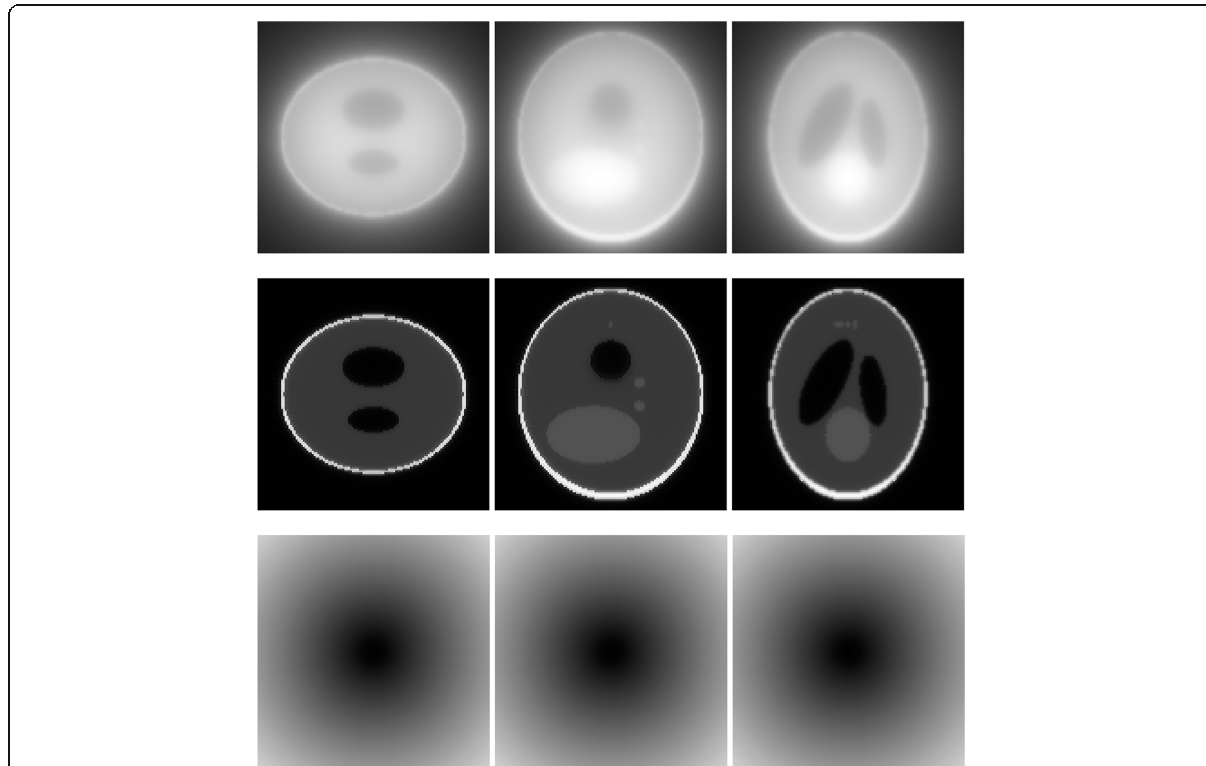
Fig. 18 Image reconstruction using non-TOF algorithm for the case of ψ = π /2. This is the ‘ 4 π ’ case. Row 1 : TOF backprojection. Row 2 : Final reconstruction. Row 3 : Tomographic filter H . Three central orthogonal cuts are shown for each row